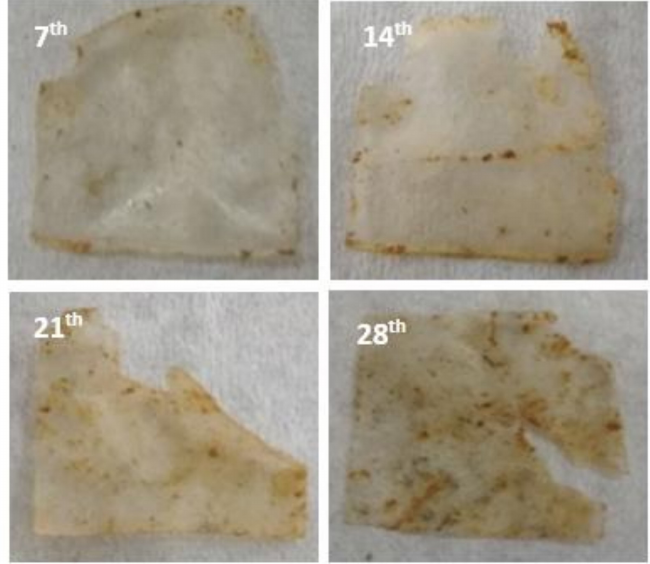
Figure 2. Physical appearance of algae film after soil burial at the 7th , 14th , 21th , and 28th